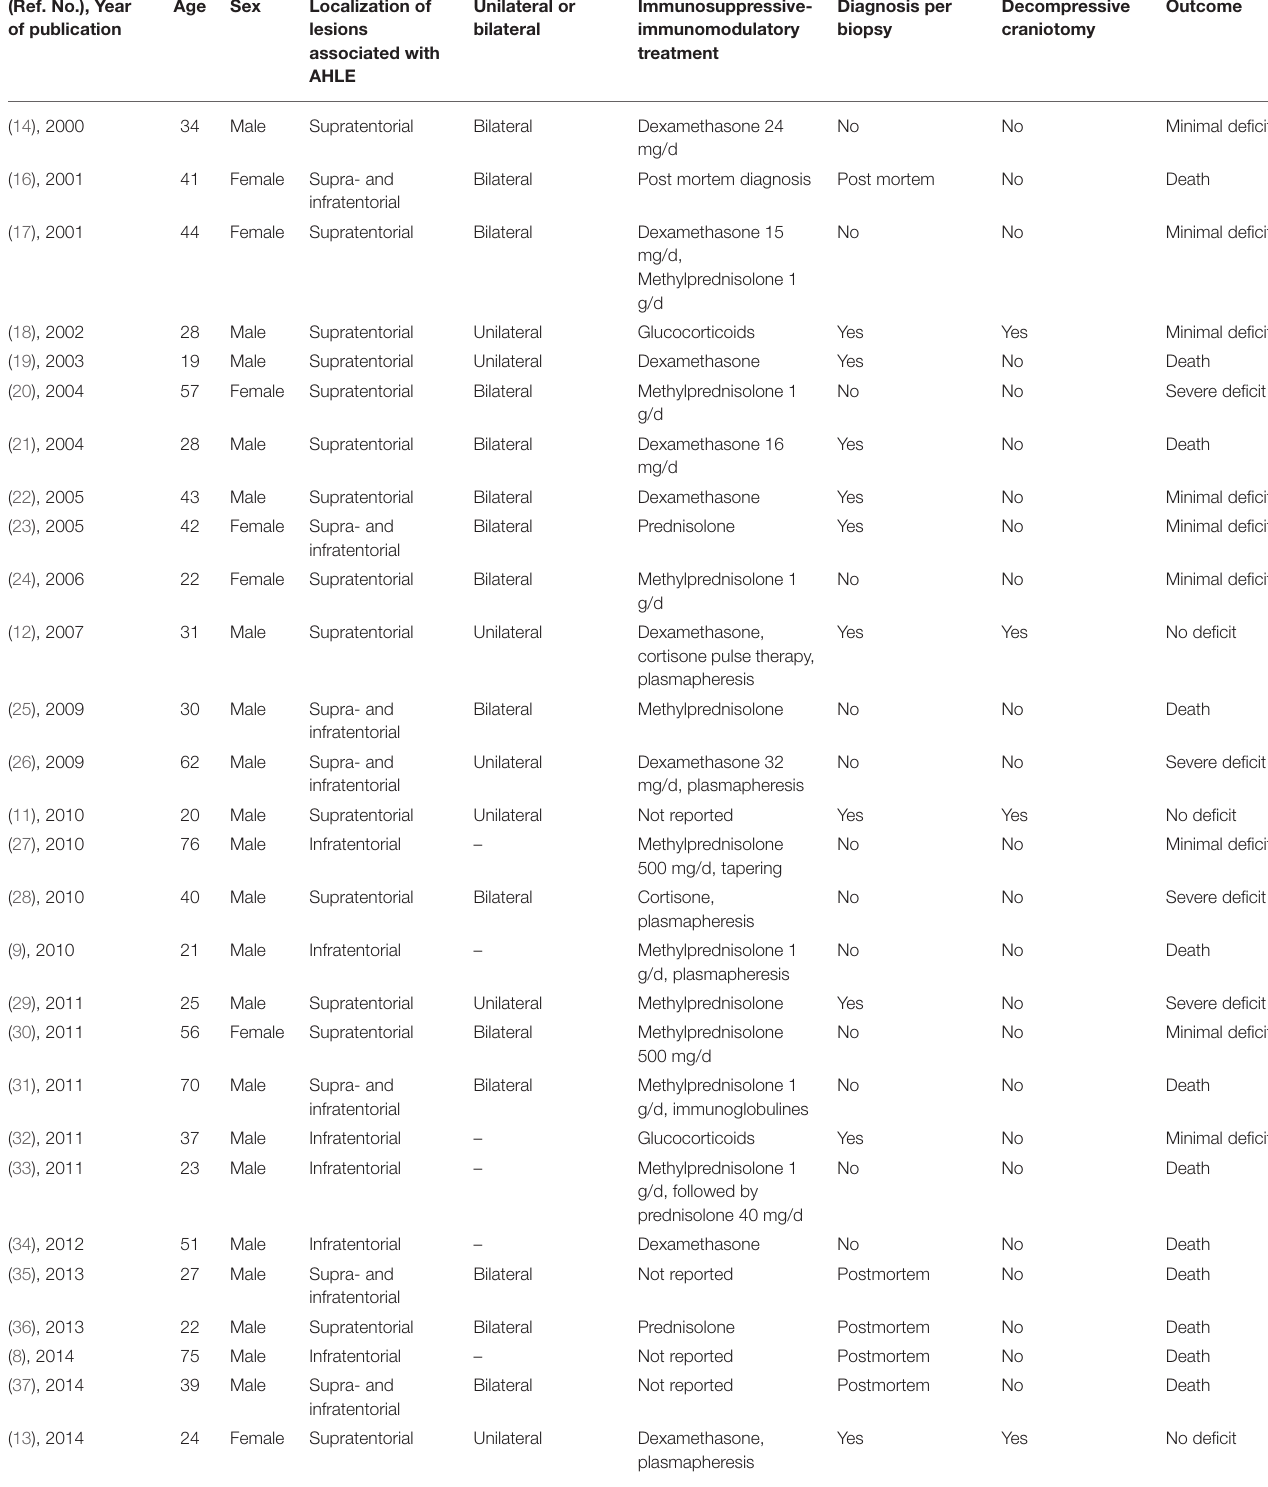
TABLE 1 | Clinical, neuroradiologic, and neuropathologic characteristics of adult patients with AHLE. (Ref. No.), Year of